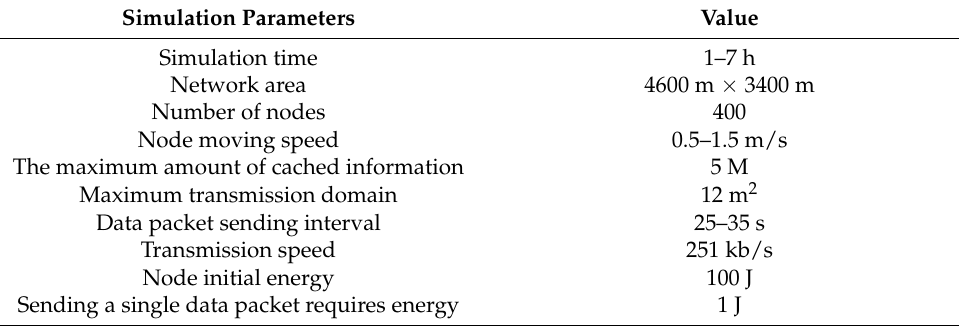
Table 2. Numerical values of experimental